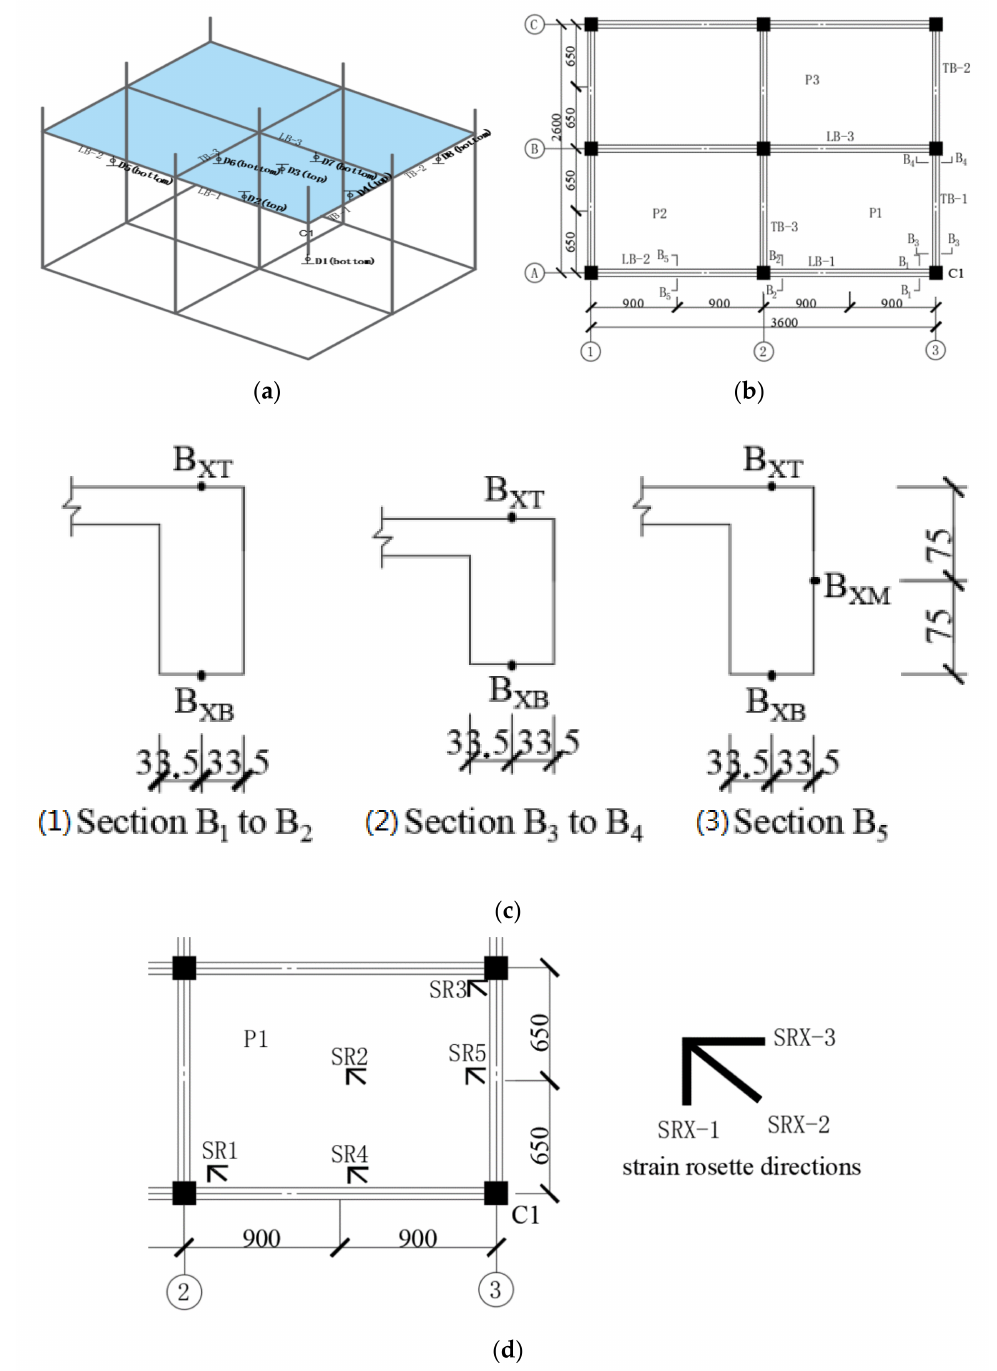
Figure 5. Layout of displacement and strain measuring points, ( a ) arrangement of displacement transducers, ( b ) strain gauge arrangements of beams (dimension unit: mm), ( c ) detailed locations of concrete strain gauges at the beam section level (dimension unit: mm), ( d ) strain rosettes arrange- ments of slab (dimension unit: